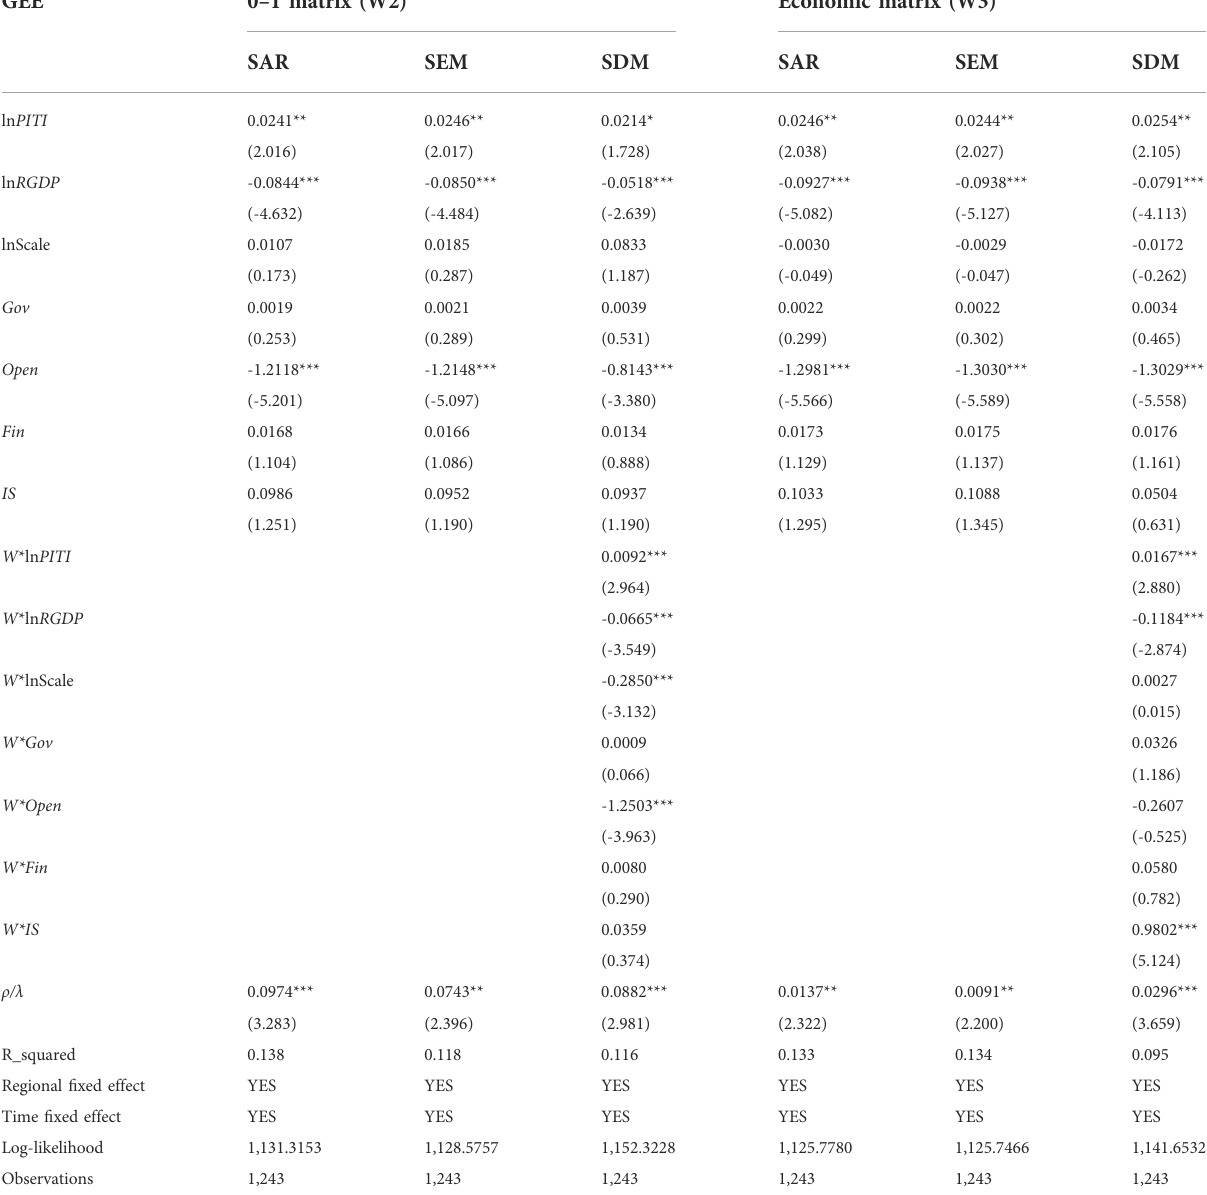
TABLE 7 Results of robustness